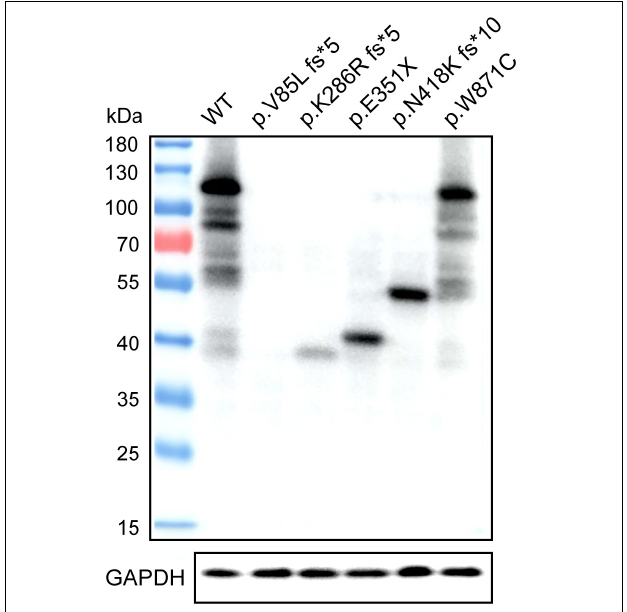
FIGURE 6 | Expression of wild-type TEX11 and the mutant variant in HEK293 cells. Western blotting results stained for anti-Myc antibody with HEK293 cells transiently transfected with wild-type TEX11-Myc, TEX11-mutant (p.V85L fs*5)-Myc, TEX11-mutant (p.K286R fs*5)-Myc, TEX11-mutant (p.E351X)-Myc, TEX11-mutant (p.N418K fs*10)-Myc, TEX11-mutant (p.W871C)-Myc vectors. GAPDH served as a loading control, and molecular weight markers are shown on the